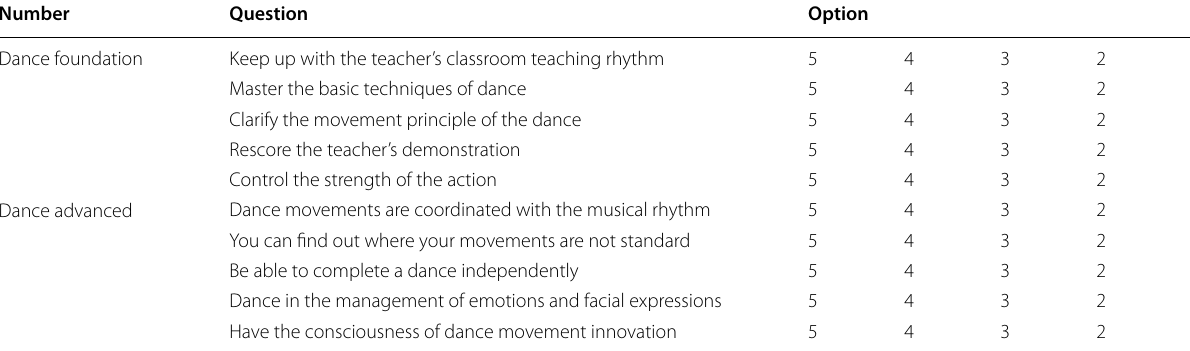
Table 3 The Dance Learning Effect Questionnaire Number